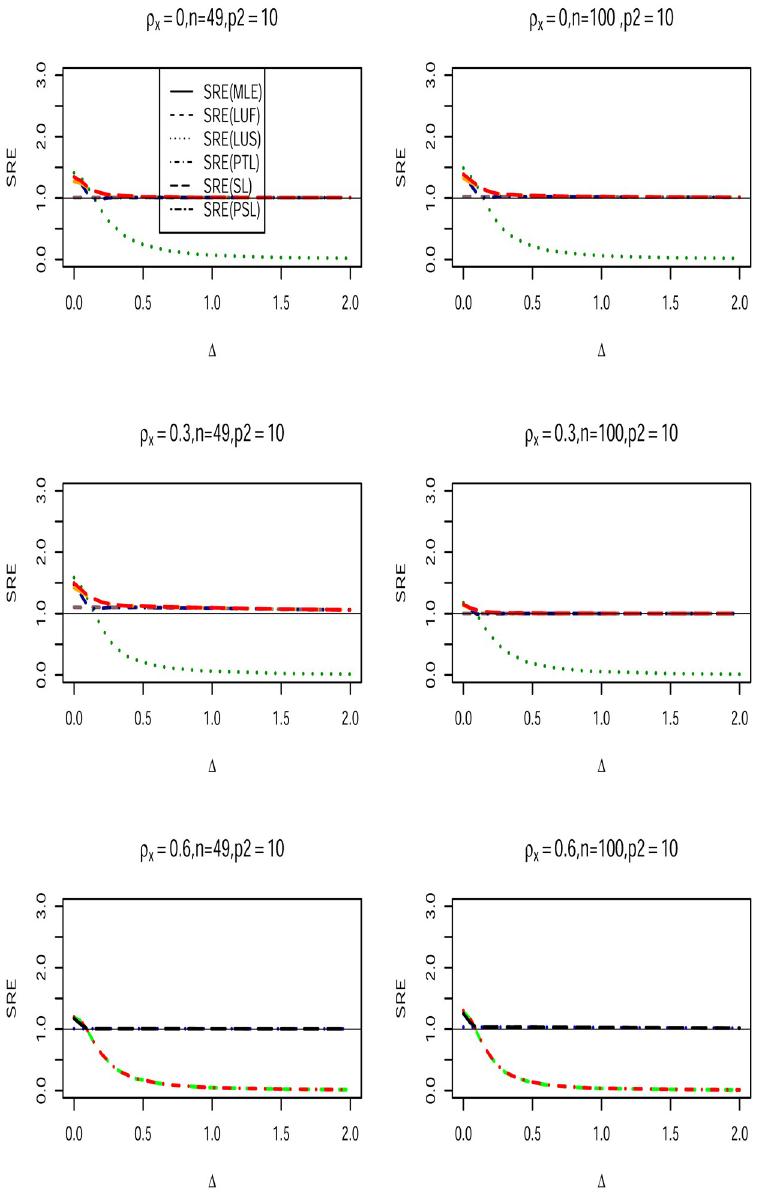
Fig 1. SRE of the proposed estimators with respect to ( ^ β p 2 ) = (5,